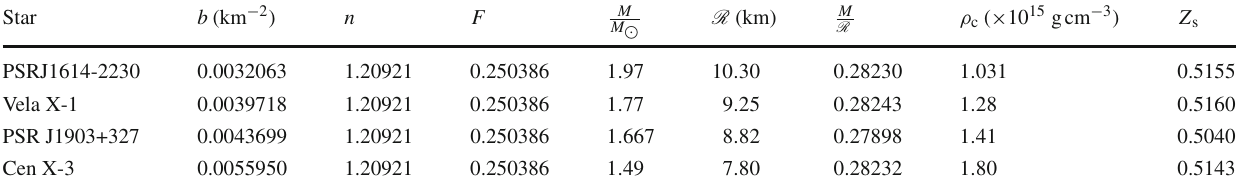
Table 2 Variation of mass, radius and central density in terms of b . The parameter b is variable and n is fixed